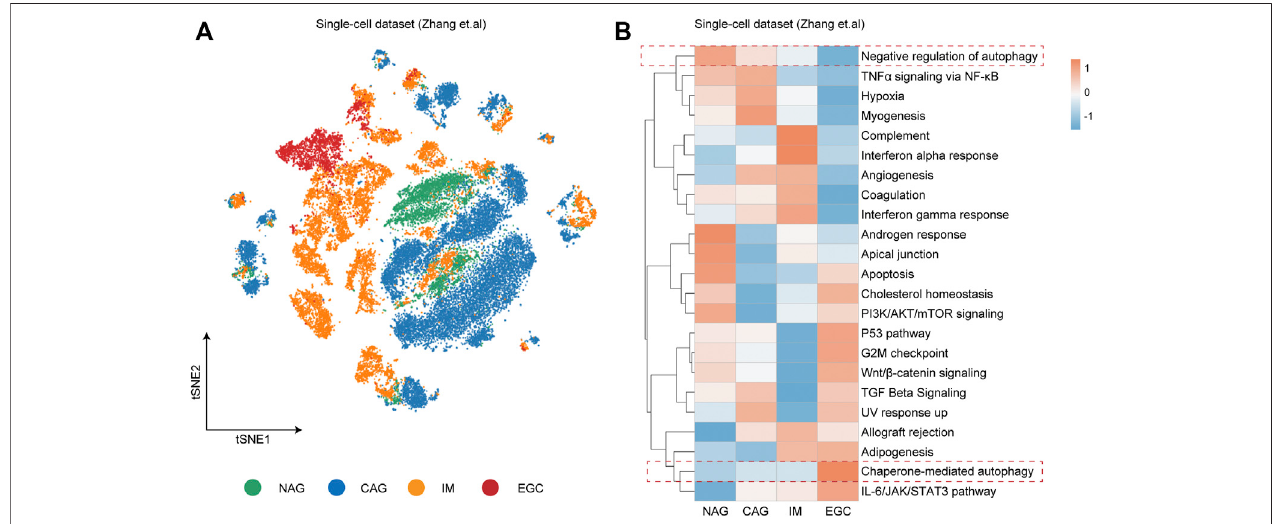
FIGURE 1 | Autophagy closely relating to the progression of gastric cancer at single-cell resolution. (A) t-distributed stochastic neighbor embedding (t-SNE) plot colored by different sample groups including non-atrophic gastritis (NAG), chronic atrophic gastritis (CAG), intestinal metaplasia (IM), and early gastric cancer (EGC). (B) Heatmap showing the expression-based pathway activities scored per cell within different sample groups as indicated in (A) .